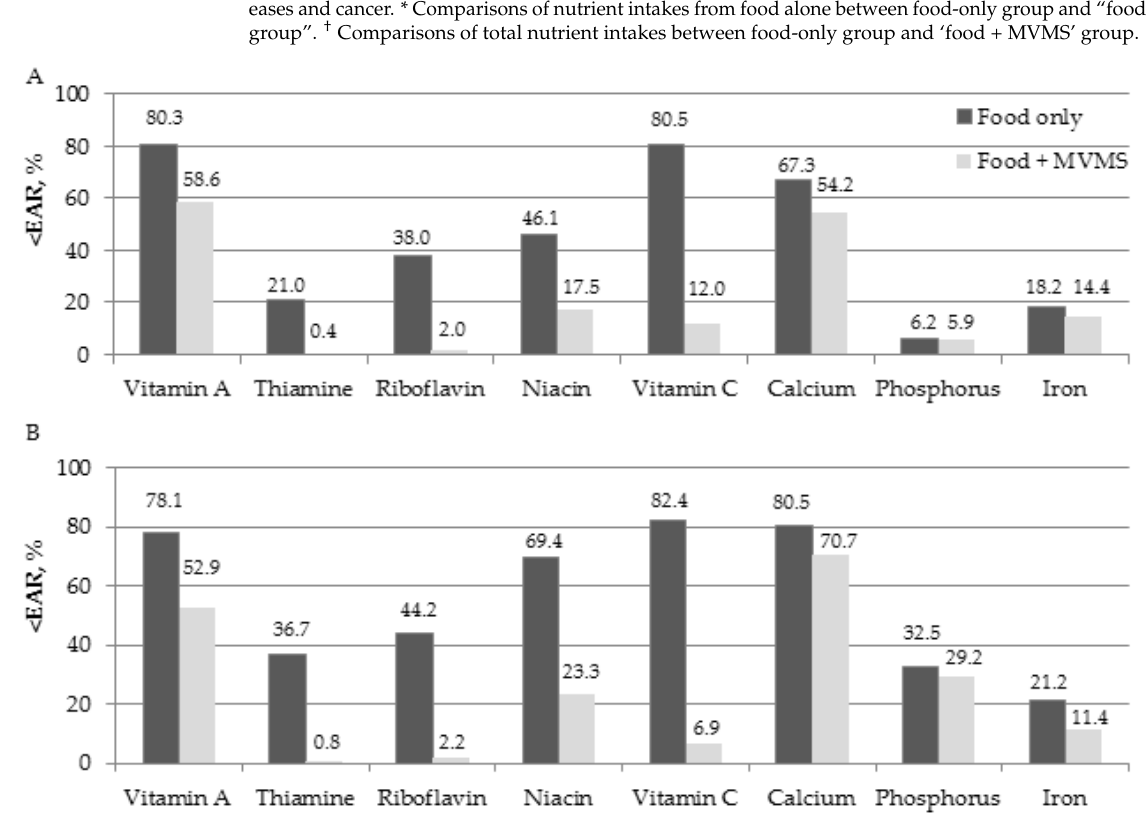
Figure 2. The percent of elderly whose intake was below EAR before and after taking MVMS in the MVMS user group; ( A ) males and ( B ) females. Abbreviations: EAR, estimated average requirement; MVMS, multi-vitamin and mineral supplements.